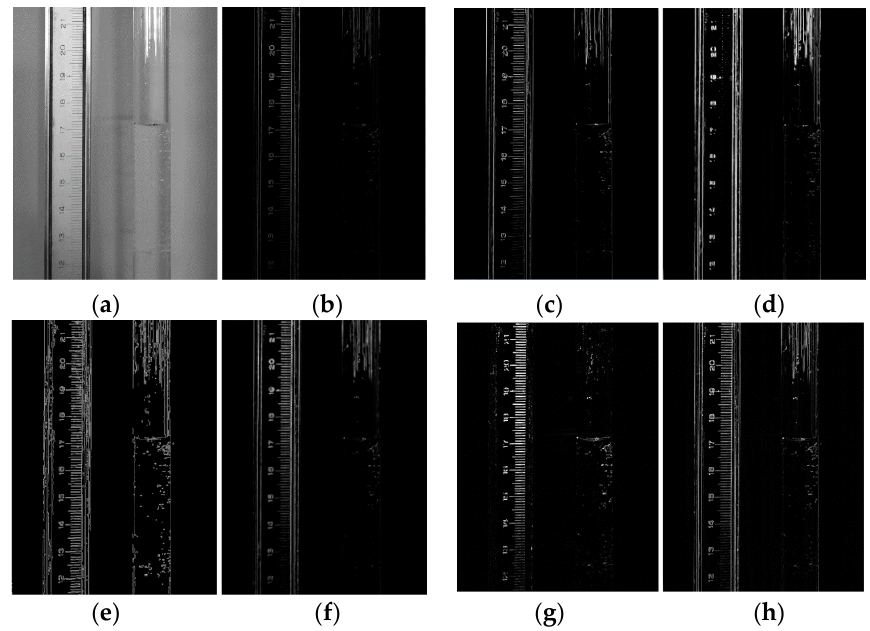
Figure 6. Edge detection results for the ( a ) grayscale image of the original graph using various operators, including the ( b ) Roberts, ( c ) Prewitt, ( d ) Sobel (X direction), ( e ) Sobel (Y direction), ( f ) Sobel (standard), ( g ) Canny, and ( h ) Laplace operators.